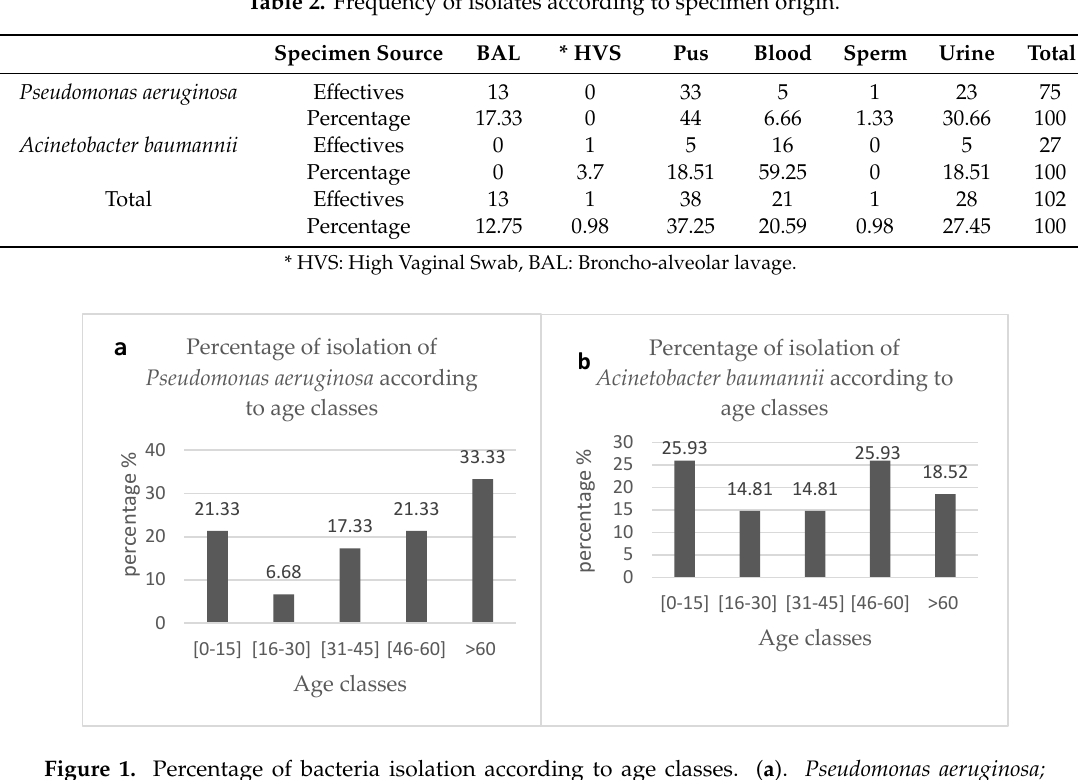
Figure 1. Percentage of bacteria isolation according to age classes. ( a ). Pseudomonas aeruginosa; ( b ). Acinetobacter baumannii.